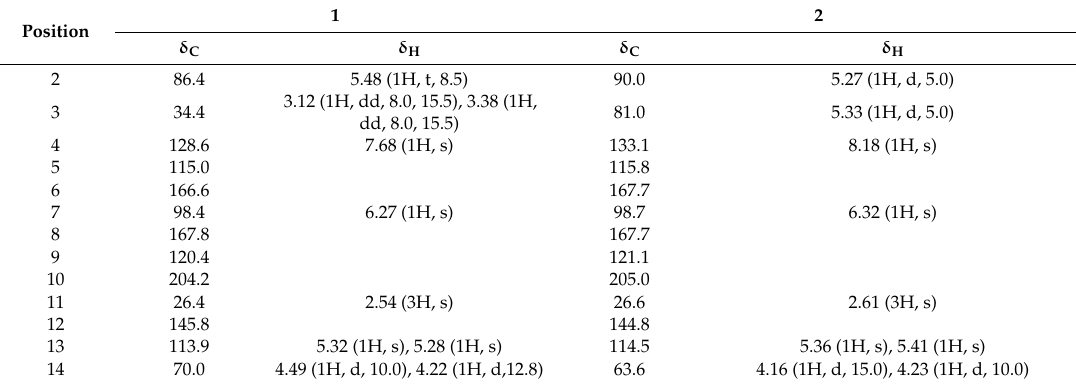
Table 1. 13 C-NMR spectroscopic data of compounds 1 and 2 (500 MHz for 1 H and 125 MHz for 13 C data, J in Hz, recorded in CD 3